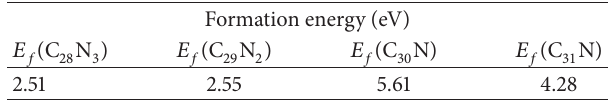
Table 3: Calculated relative energies of N-doped graphenes. The relative energies 𝐸 1 – 𝐸 4 are defined in (2)–(5),